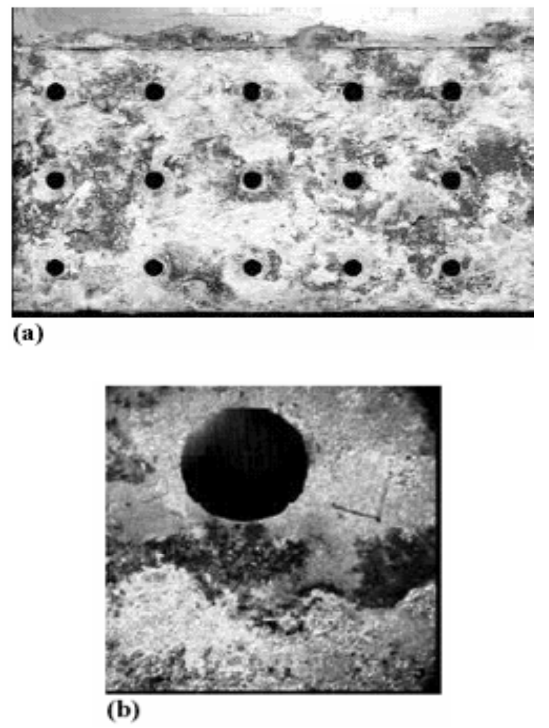
Fig 3. MSD specimen corroded to 5% to 6% average thickness loss: (a) countersunk sheet with corrosion product still in place,